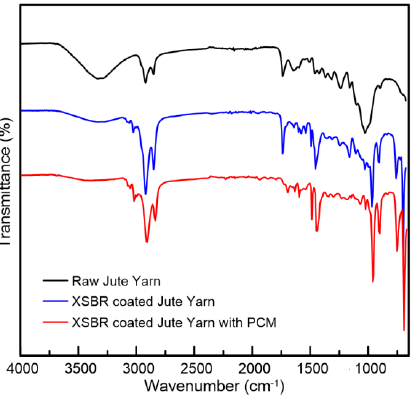
Figure 11. FTIR spectroscopy of untreated and treated jute